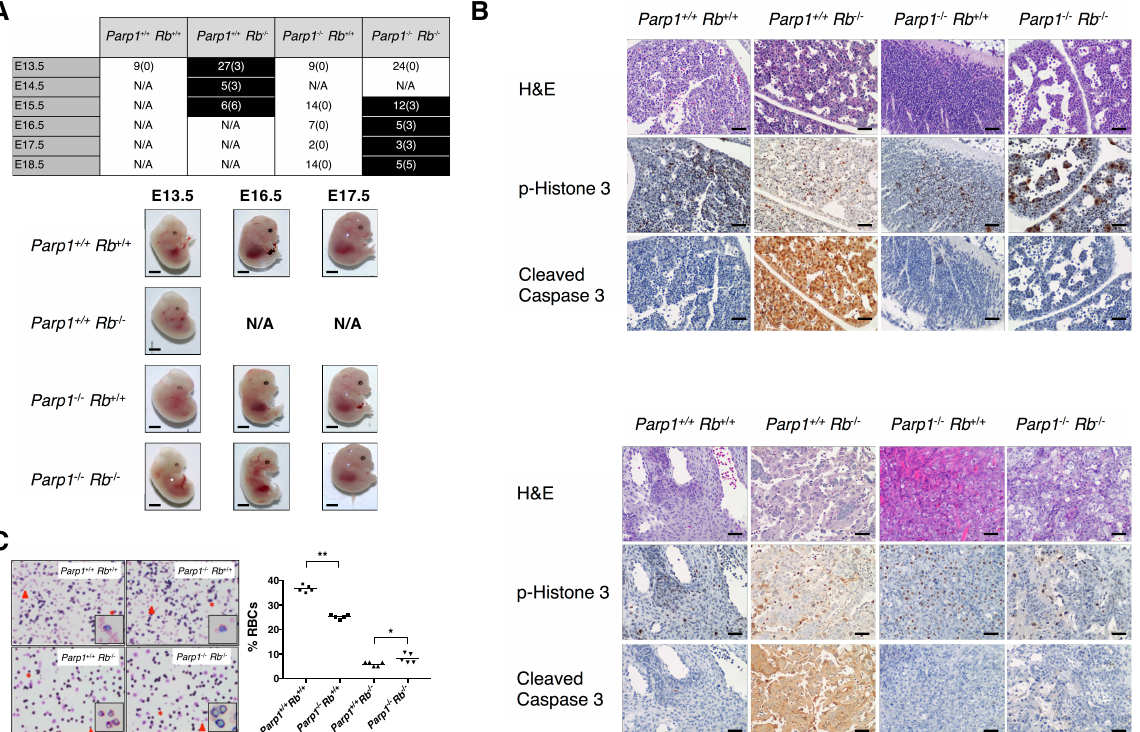
Figure 1. Genetic deletion of Parp1 restores the phenotypic alterations induced by E2F1 hyperactivation in Rb - / - embryos. ( A ) Summary of embryos analysed from each genotype at di ff erent gestational ages. Non-viable embryos are denoted in brackets. Timepoints a ff ected by embryonic lethality are highlighted in black. While Parp1 +/+ Rb − / − mice display embryonic lethality at circa E13.5, Parp1 − / − Rb − / − mice show a delay until E16.5 ( p < 0.05). Lower panel exhibits the macroscopic di ff erences of the di ff erent genotypes at E13.5, E16.5 and E17.5. Rb +/ - embryos at E16.5 and E17.5 are not displayed due to embryo resorption. Solid arrowheads highlight functional vascularization and liver integrity at E16.5 and E17.5 in Parp1 − / − Rb − / − , resembling those of other viable genotypes Scale = 1 mm. ( B ) Histological analysis of foetal liver tissue at E13.5. Unlike Rb -deficient mice, double knock-out embryos do not display high levels of cleaved caspase 3, a hallmark of apoptosis. Staining of phospho-histone 3 reveals a significant rate of proliferation, not much di ff erent than that of wild-type or Parp1 knock-out mice. Scale (40 × ) = 25 µ m. Histological analysis of placental tissue revealed massive apoptosis in cells lacking retinoblastoma, while Parp1 − / − Rb − / − placentas displayed a slight increase in cleaved caspase 3 staining compared to samples from wild-type or Parp1 - / - mice. Scale (40 × ) = 25 µ m. ( C ) Counting of enucleated red blood cells (RBCs) showed a drop-in cell numbers of both retinoblastoma-deficient groups that is not observed Parp1 - / - Rb - / - mice (* p < 0.05; ** p < 0.002). Scale (40 × ) = 25 µ